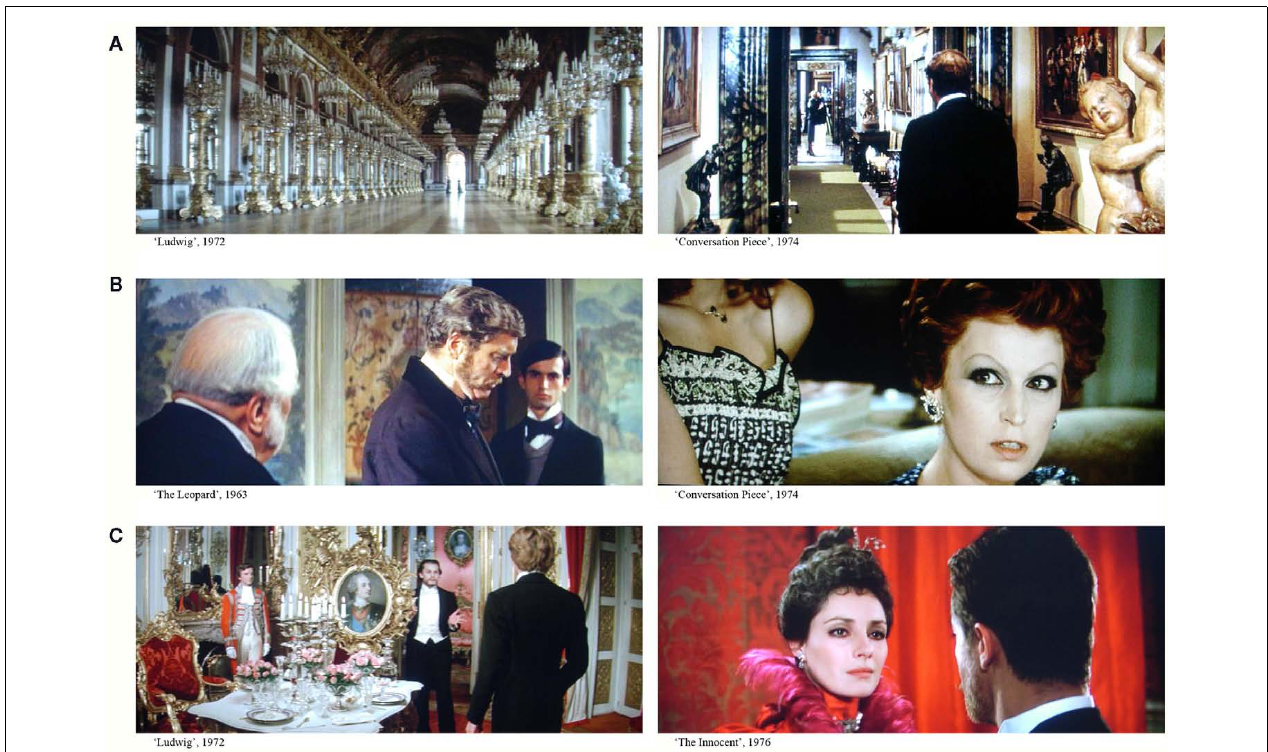
FIGURE 6 | LuchinoVisconti. (A) Representation of space in “Ludwig” (left) and in “Conversation Piece” (right). (B) Spatial complexity of gaze and